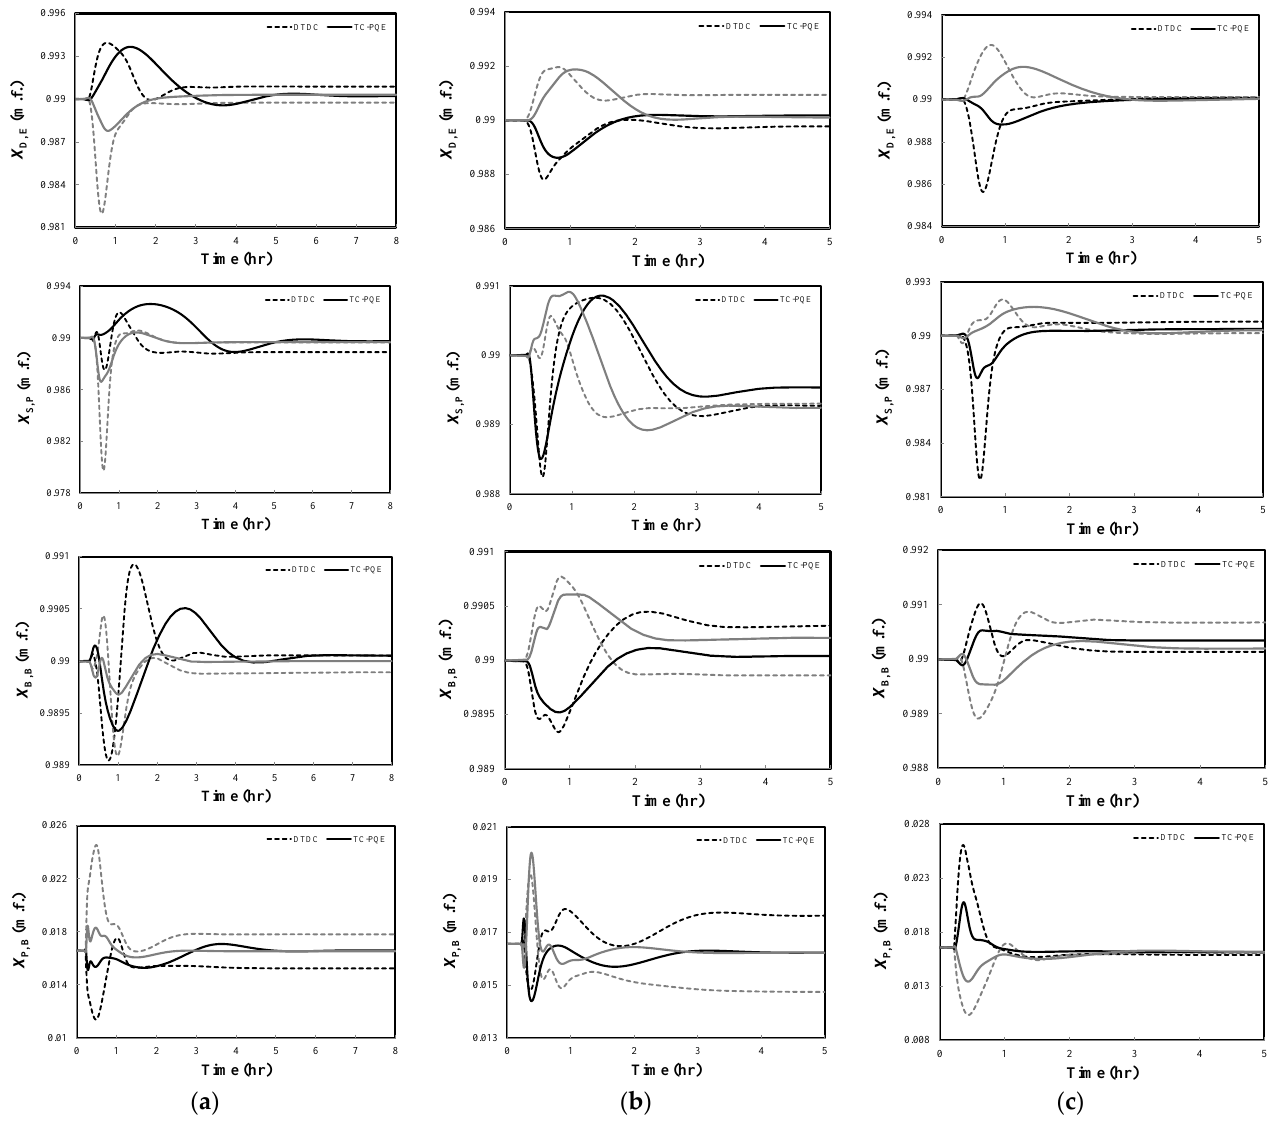
Figure 7. Variations of the product purities as maintained with the DTDC and TC-PQE schemes for ±20% variations in feed compositions (Example I): ( a ) E; ( b ) P; ( c ) B. (Black line: positive disturbance; grey line: negative disturbance).